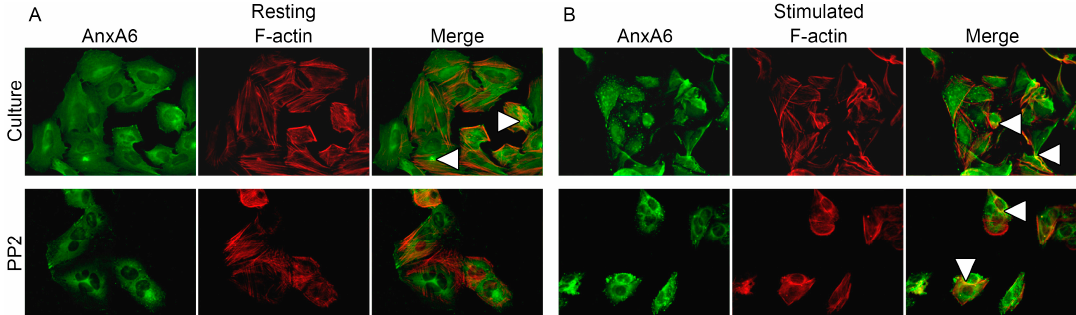
Figure 4. Co-localization of AnxA6 with F-actin in Saos-2 cells, non-treated (Culture) or treated with inhibitors, in resting conditions ( A ) or after seven-day stimulation with AA and β -GP ( B ). The cells were incubated with appropriate probes: mouse monoclonal anti-AnxA6 linked with goat-anti mouse Immnoglobulin G (IgG)-fluorescein isothiocyanate (FITC) and phalloidin-TexasRed recognizing F-actin and observed under an Axio Observer Z1 fluorescent microscope (Carl Zeiss, Oberkochen, Germany) with phase contrast and appropriate fluorescent filters, magnification 240 × . The yellow color and arrowheads on the merge images indicate protein co-localization. Data of a typical experiment are presented.